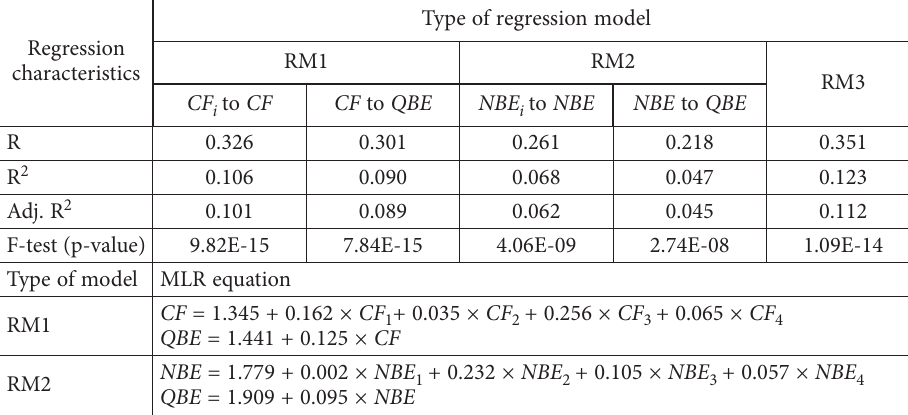
Table 3. Regression characteristics of the regression models (source: own data collection)